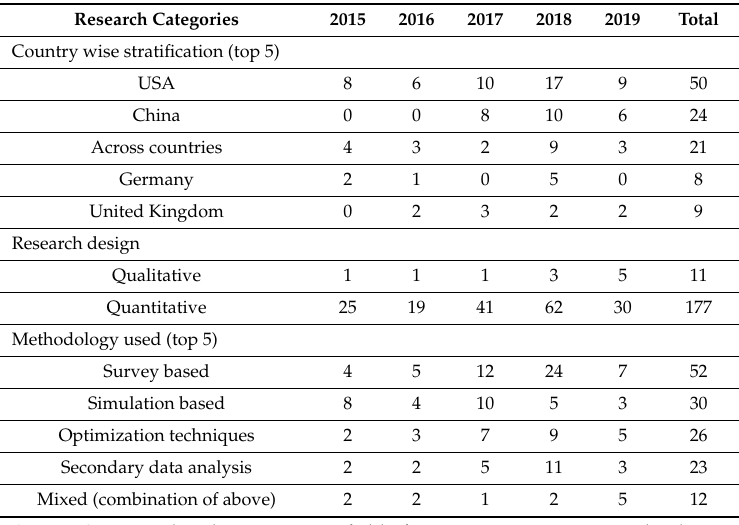
Table 2. Trend of the relevant studies in recent years 1